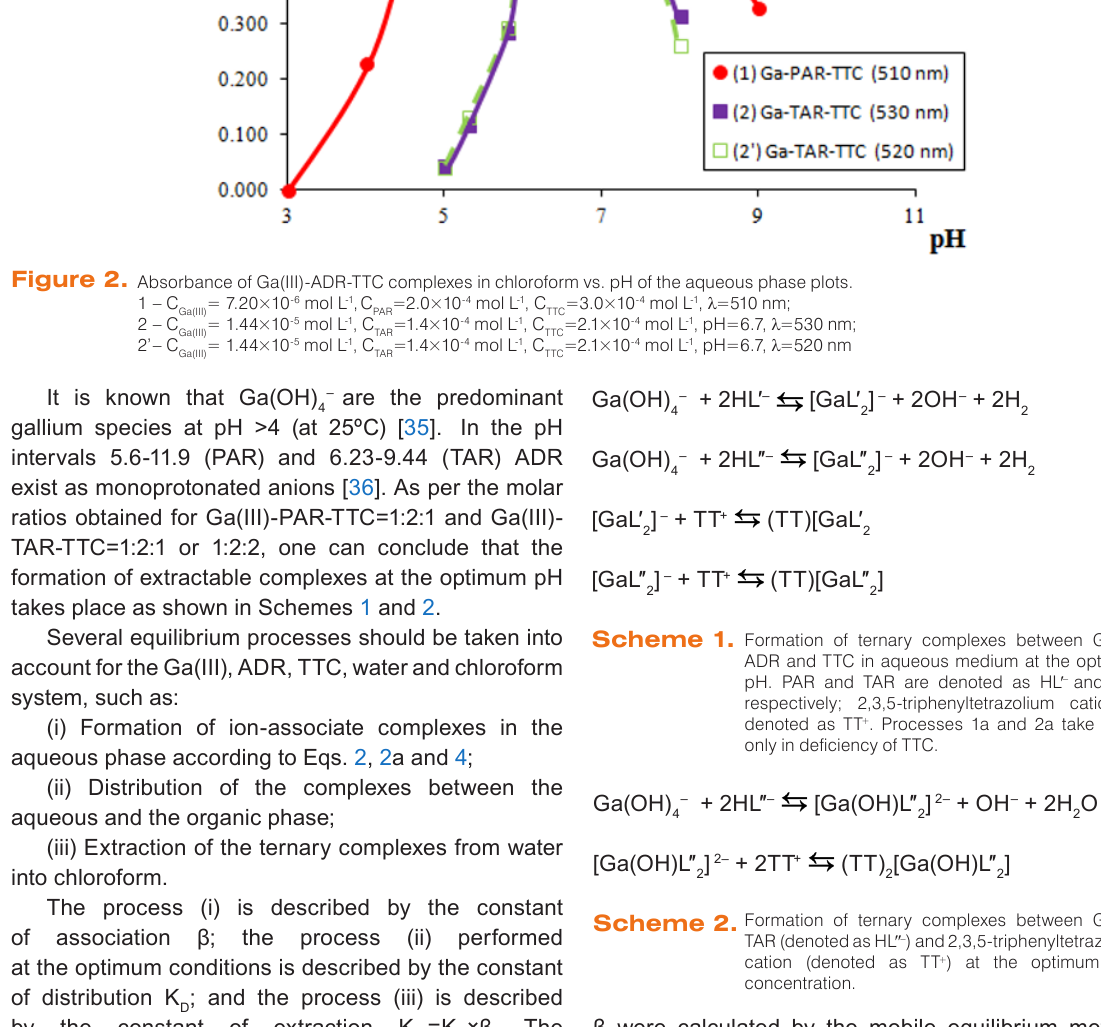
method [37] (see the results in Tables 3 and 4). of 95%.